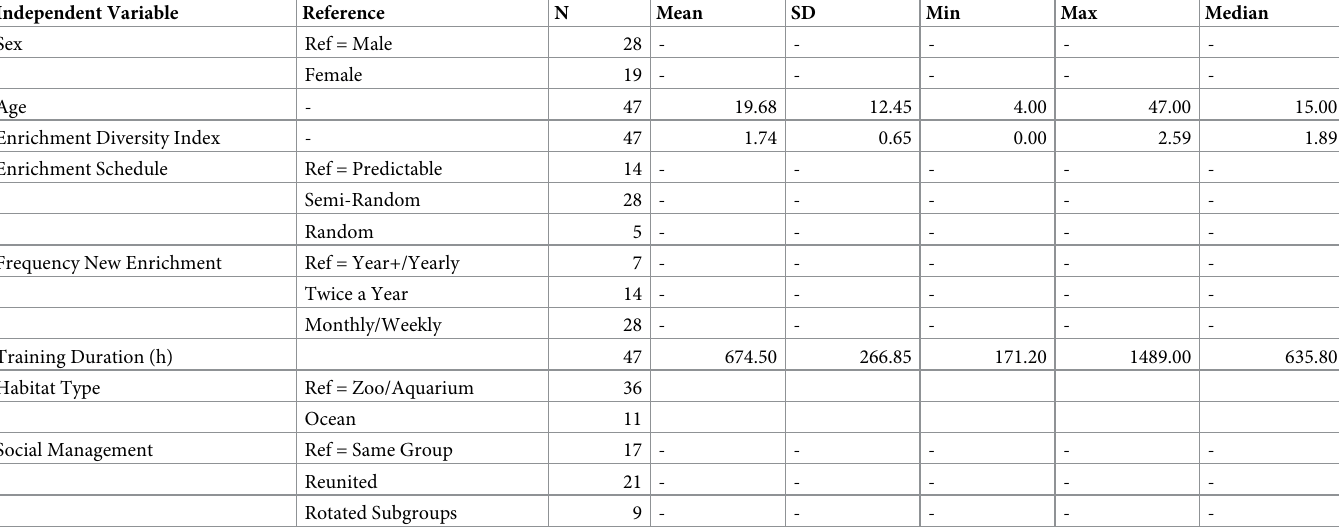
Table 6. Descriptive statistics for independent variables considered for multivariate model of group active .